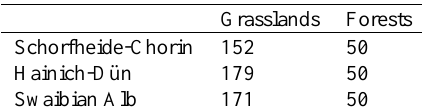
Table 1: Number of observations available in each exploratory for grasslands and forest plots.